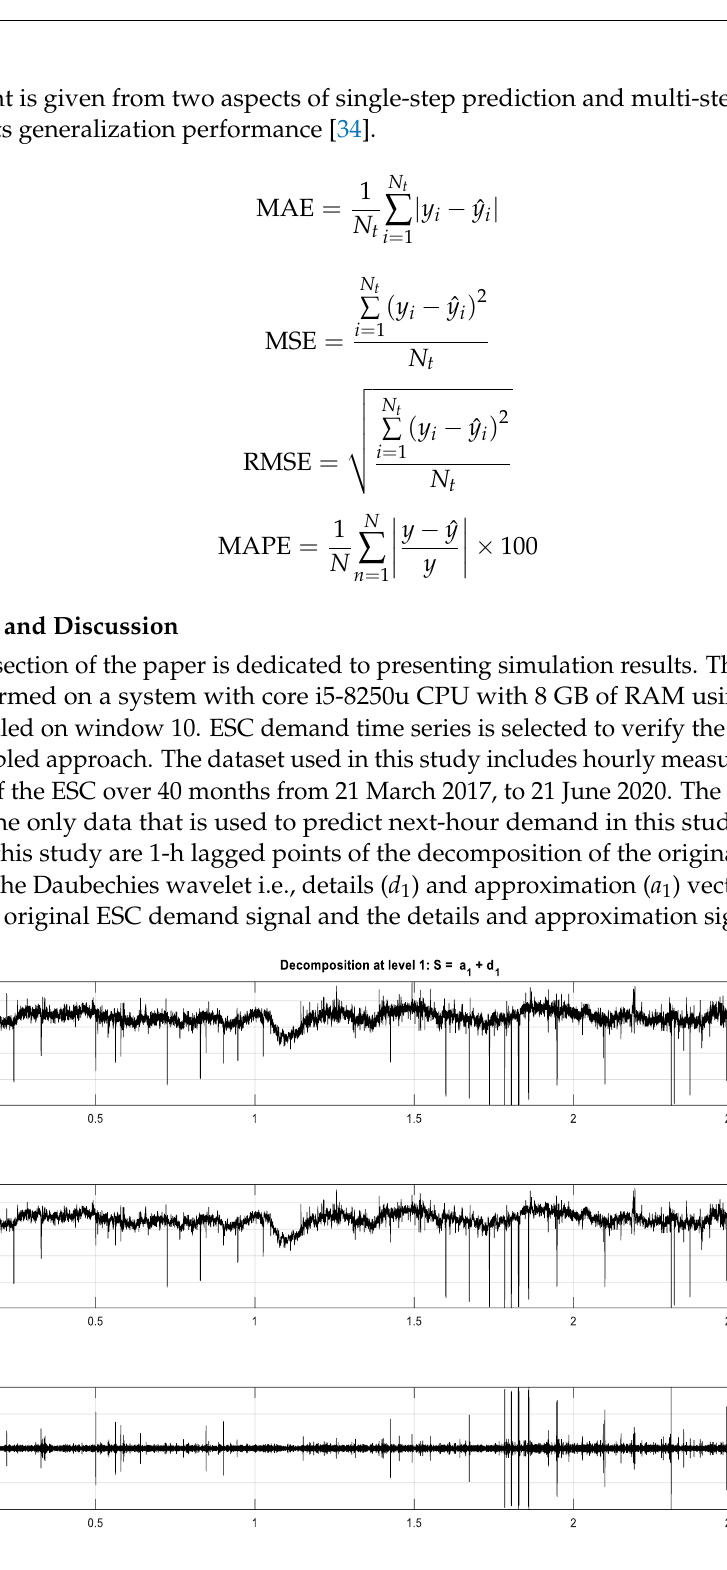
Figure 4. Illustration of the ESC demands time series, approximation, and details vectors obtained using the Daubechies wavelet.